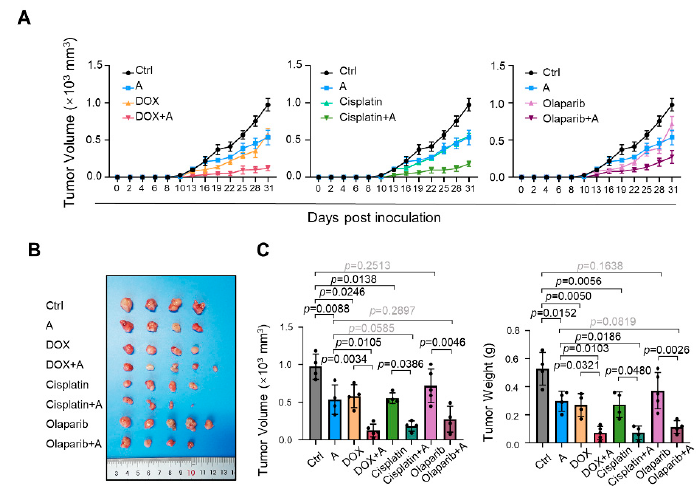
Figure 12. Chemical A enhances the effects of chemotherapy drugs on tumor growth inhibition. Nude mice bearing MDA-MB-231 cells were administered chemical A in combination with doxorubicin, cisplatin, and olaparib from 10 to 31 dpi. ( A ) Tumor growth curves of mice with different treatments are presented. ( B ) Photograph showing the tumors dissected at 31 dpi. ( C ) Tumor weight and tumor volume at 31 dpi were compared. n = 4–5. The lines and error bars indicate the means ± s.e.ms.; one-way ANOVA with Tukey’s multiple comparisons test.